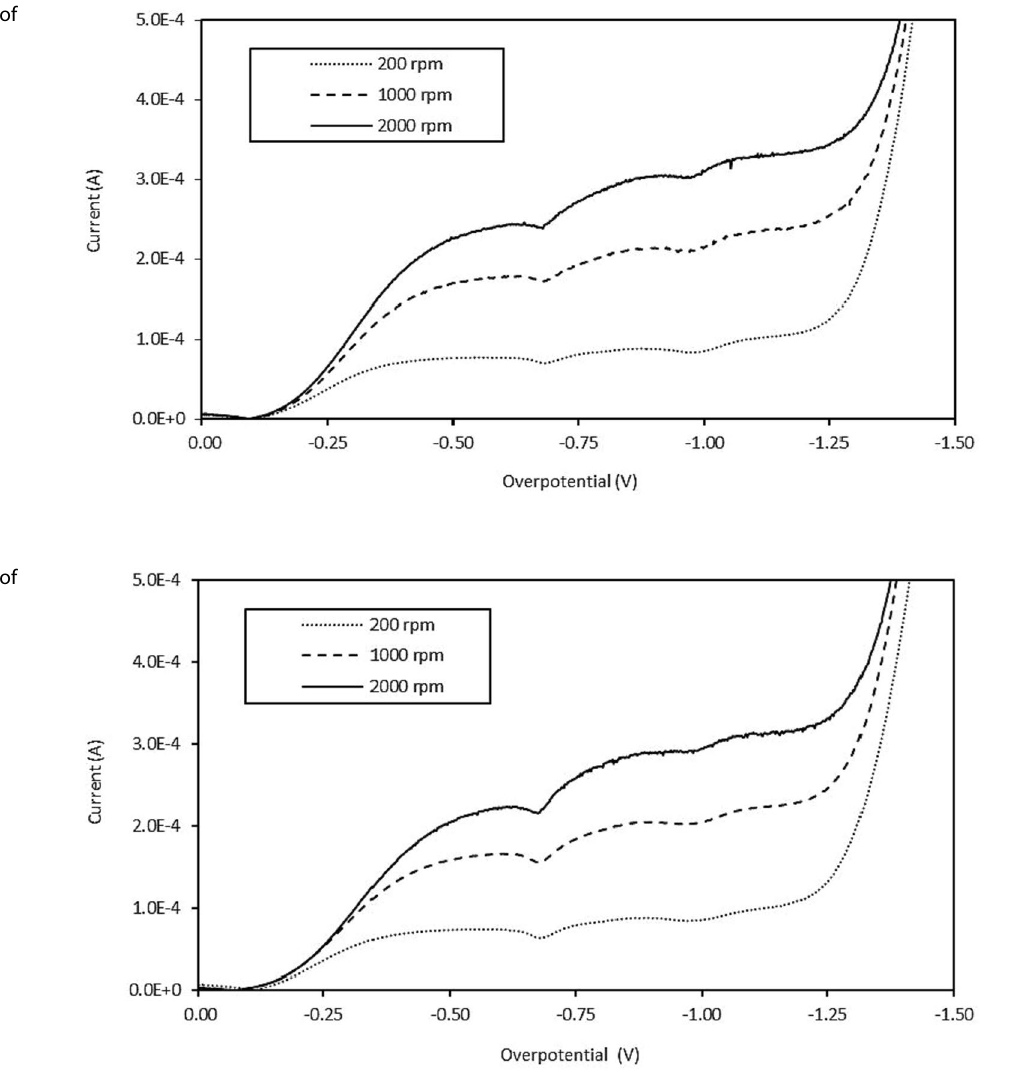
Fig. 6 IV curve for electrode of SD-HSS